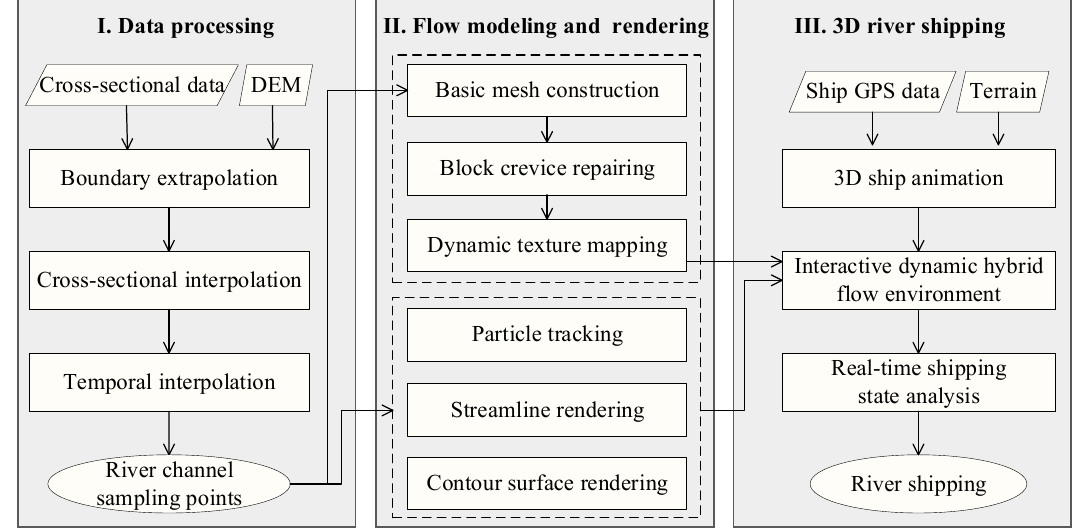
Figure 1. 3D river shipping framework.